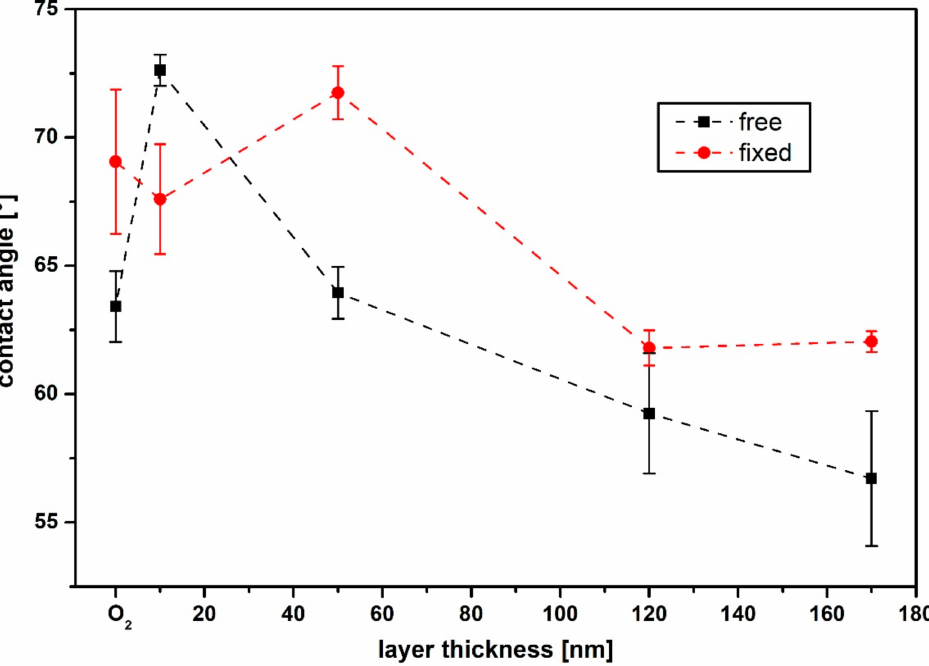
Figure 5. Contact angles of a-C:H coatings from 10 to 170 nm thickness on PHB. The red dots are the “fixed” samples, the black squares the “free” ones (the dashed line only indicates a